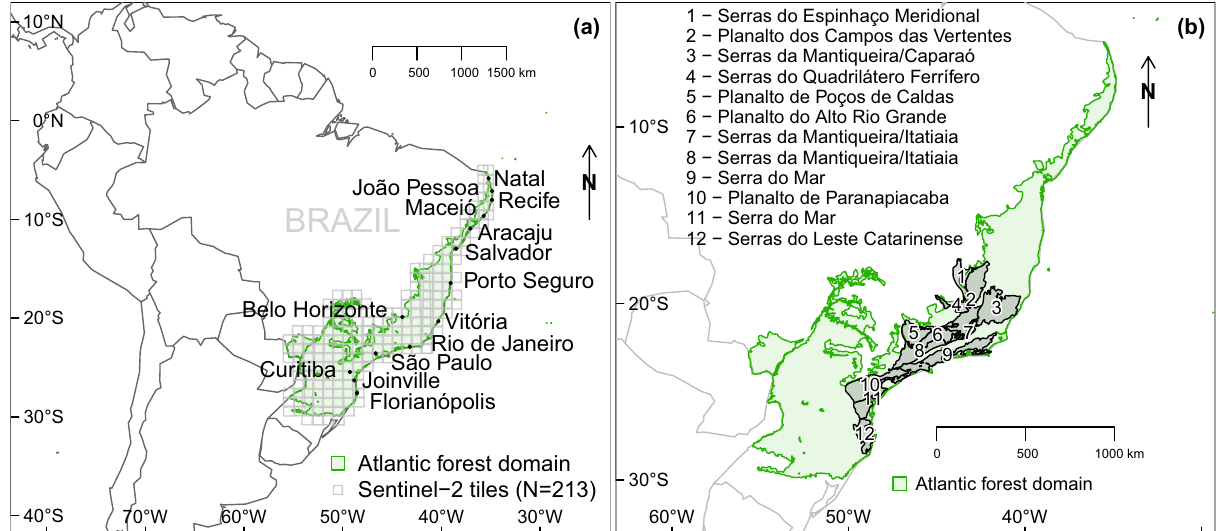
Figure 2. Geographical location of the Atlantic Forest domain in green, extents of the 213 Sentinel-2 tiles in light grey and main cities within the domain ( a ). Geographical locations and local names of principal mountain chains and high plateaus of the Atlantic Forest domain, geomorphological units respectively named Serras and Planalto in Portuguese 33 ( b